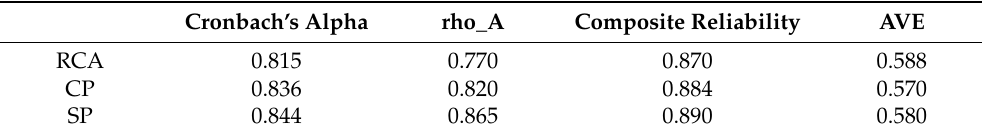
Table 5. Internal consistency and convergent validity tests.